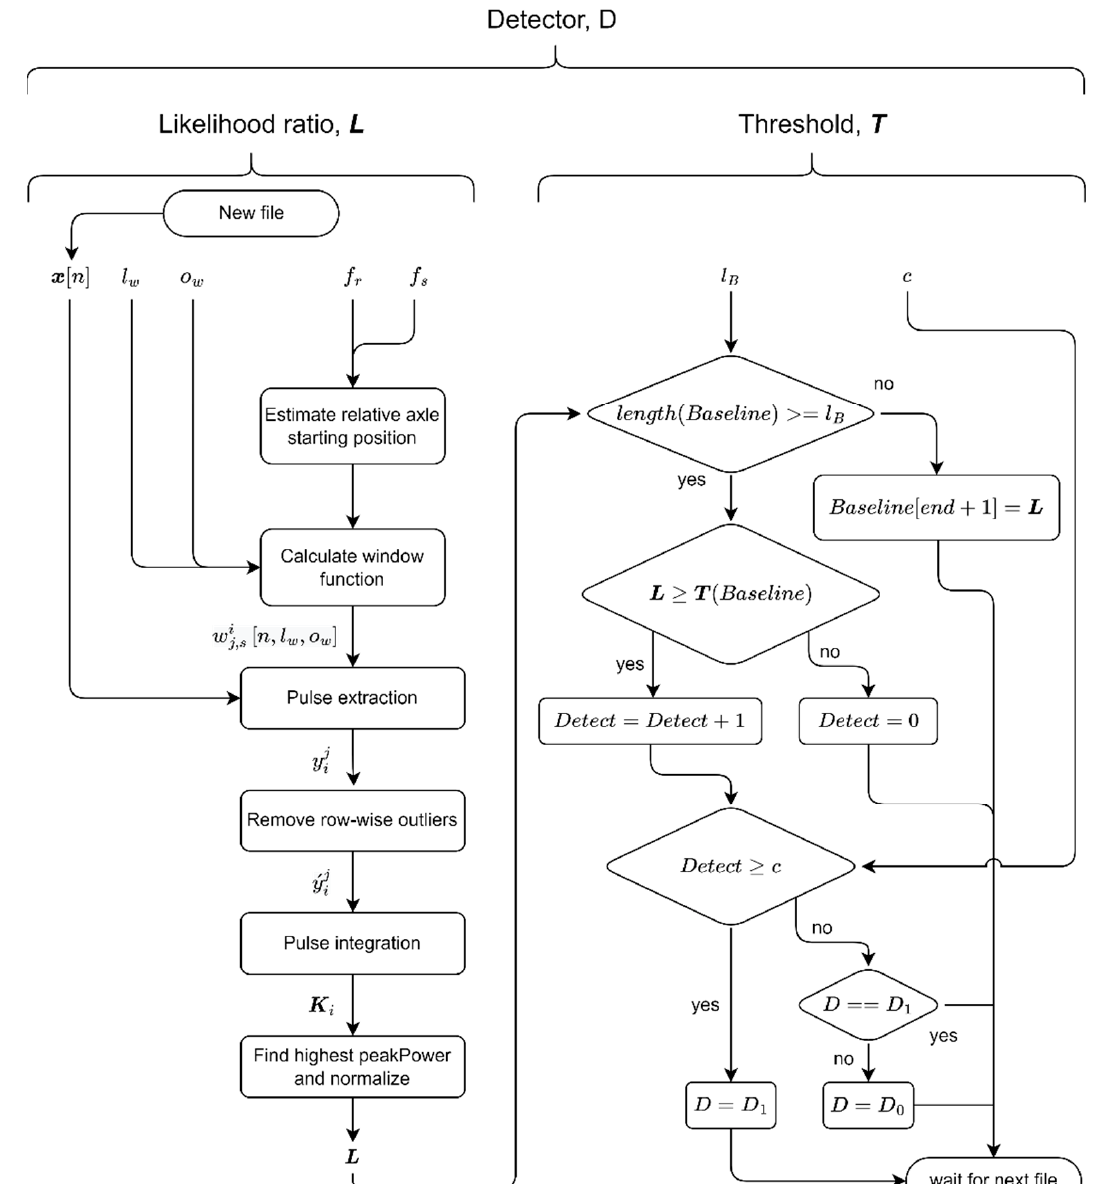
Figure 2. The flowchart illustrating the essential steps of the detection process (all variables in functions are defined in the text below).